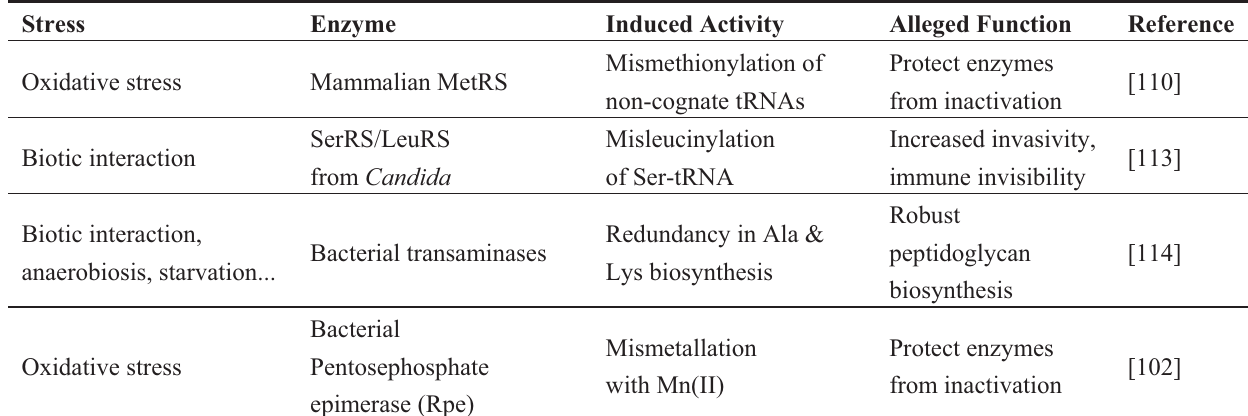
Table 1. Possible physiological benefits of various promiscuous and redundant activities induced in response to stress or environmental